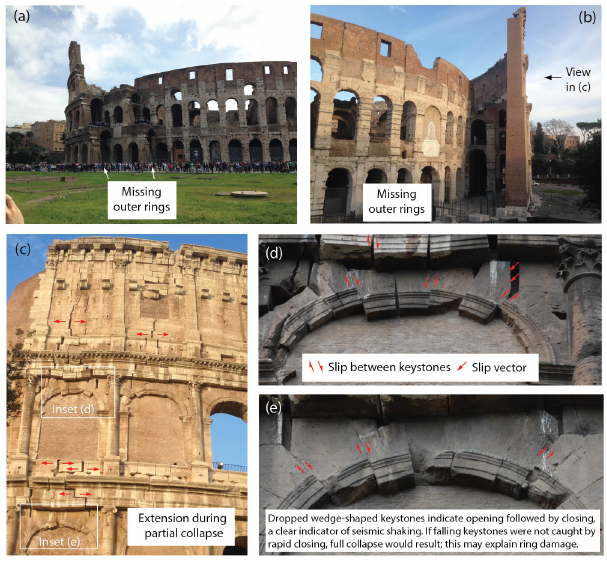
Figure 9. Damage to the Colosseum in